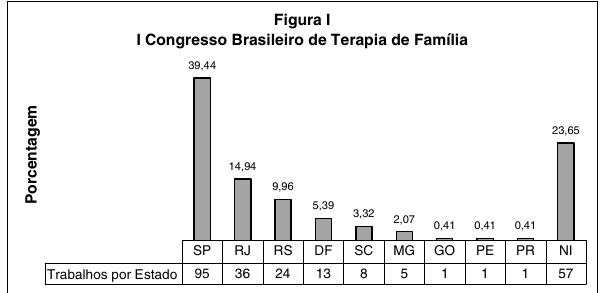
Figura 1 . I Congresso Brasileiro de Terapia de Família.